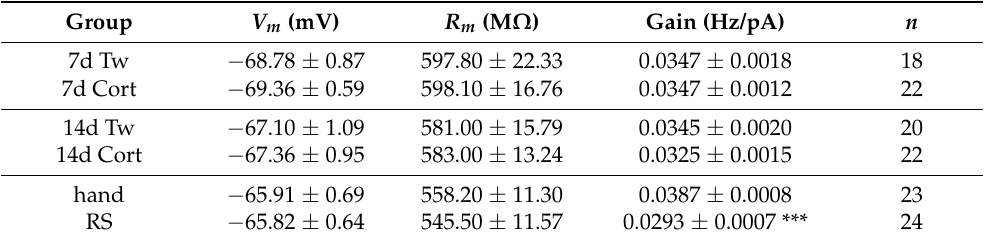
Table 1. Effects of corticosterone and restraint stress on basic electrophysiological characteristics of recorded neurons (mean ± SEM).